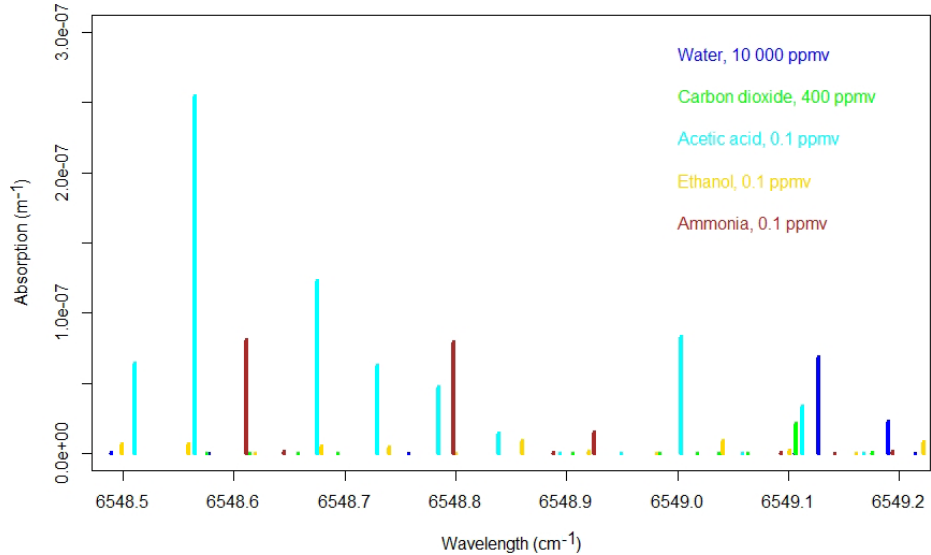
Figure 1. Simulated absorption spectrum from the HITRAN database for 1% H 2 O (blue), 400ppm CO 2 (green), 100ppb acetic acid, 100ppb ethanol, and 100ppb NH 3 at 45 ◦ C and